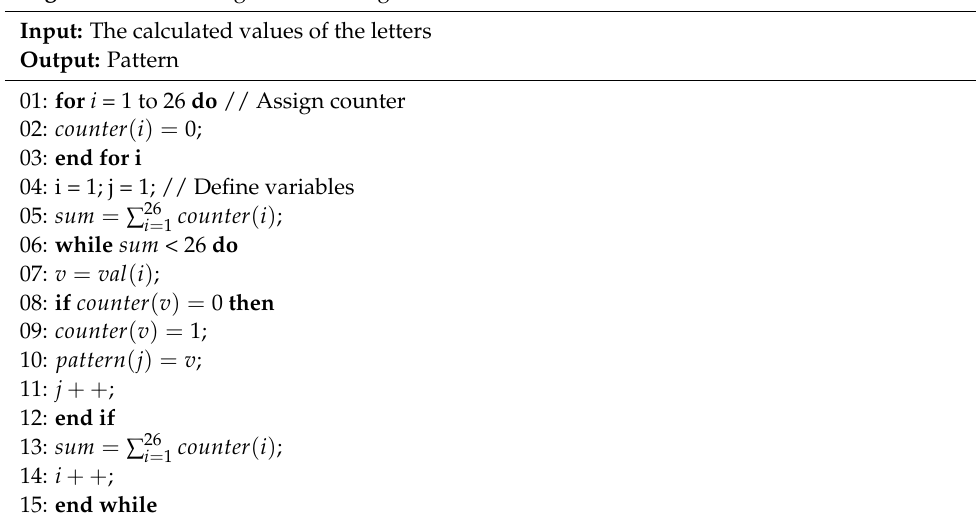
Figure 3. Frequency histogram of the enumerated letters used in the selected Hamlet text. 5: Generate a pattern by deploying Algorithm 1. Algorithm 1. Pattern generator using enumerated